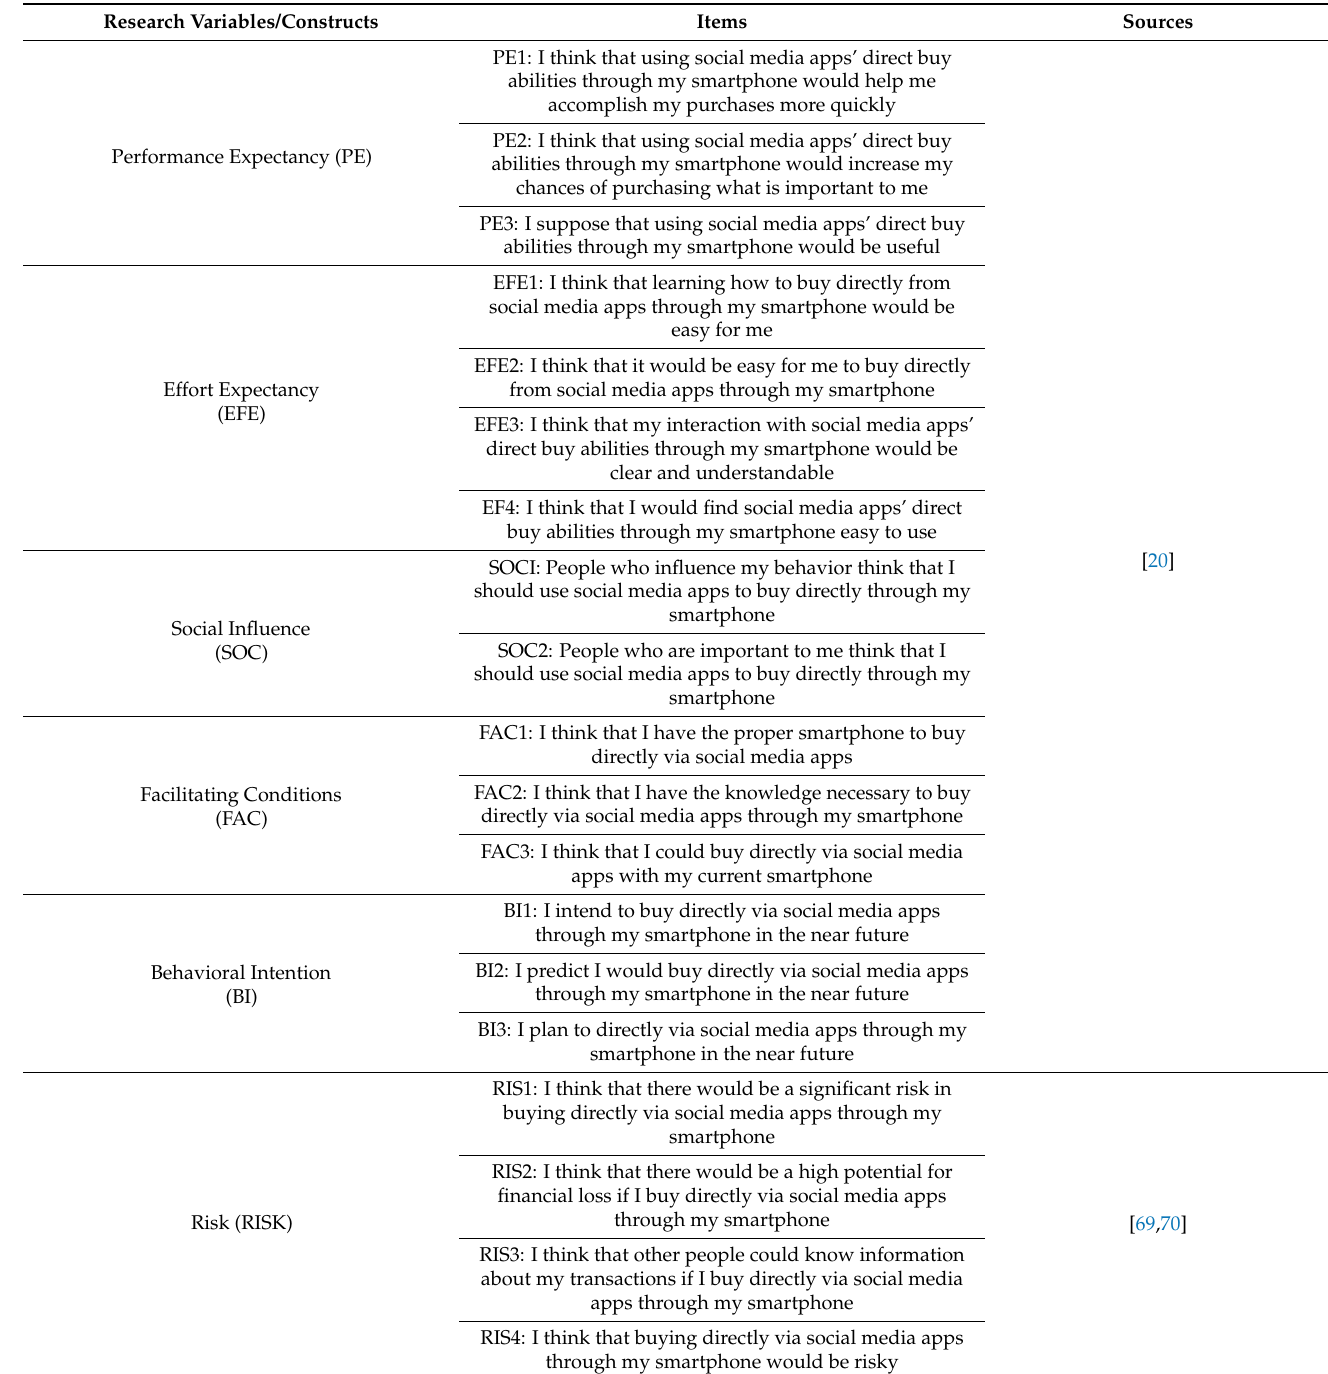
Table A1. Measurement Instrument –